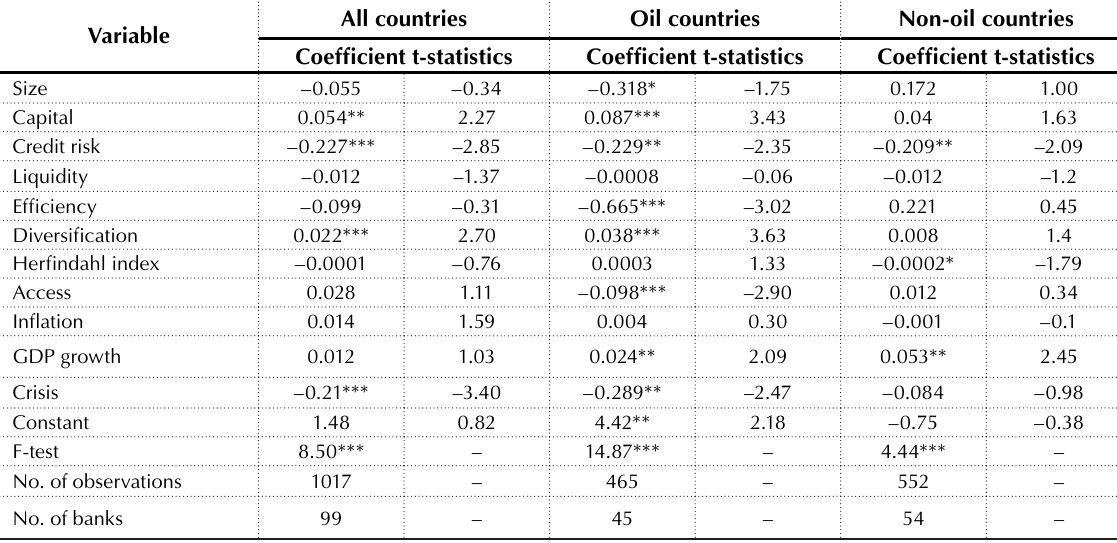
Table 6. Fixed effects results (regular reporting